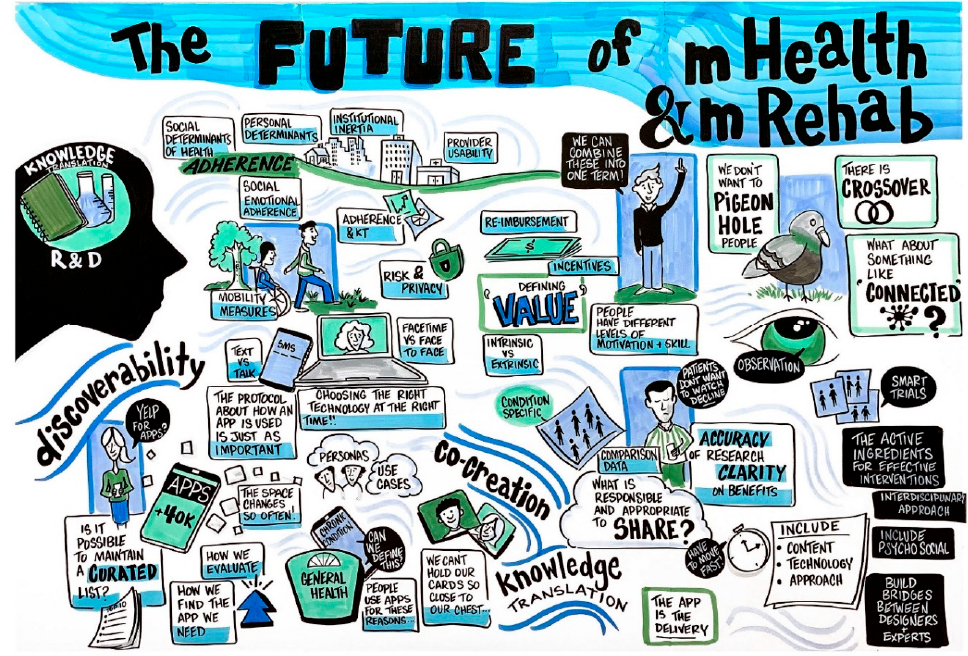
Figure 3. Graphic recording from session on The Future of mHealth and mRehab for People with Disabilities.